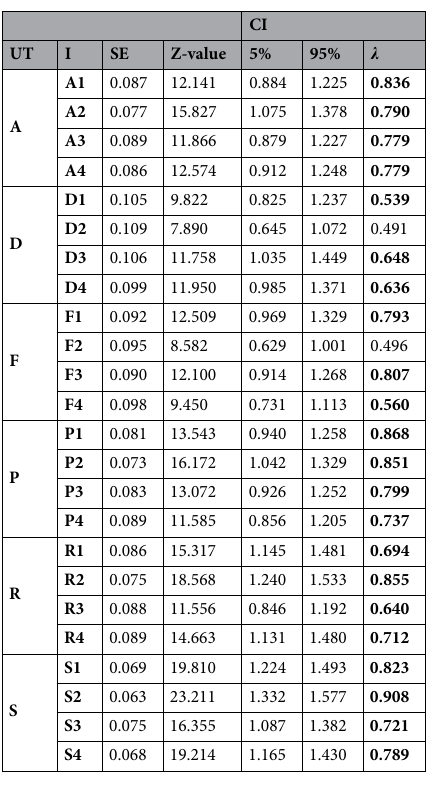
Table 1. Factor loadings. N = 421. UT: User types/factors; I: Items; SE: standard errors; CR: critical ratios; CI: Confidence interval; (cid:31) : standardized (cid:31) ; bold: (cid:31) ≥ 0.500; A: Achiever; D: Disruptor; F: Free Spirit; P: Philanthropist; R: Player; S: